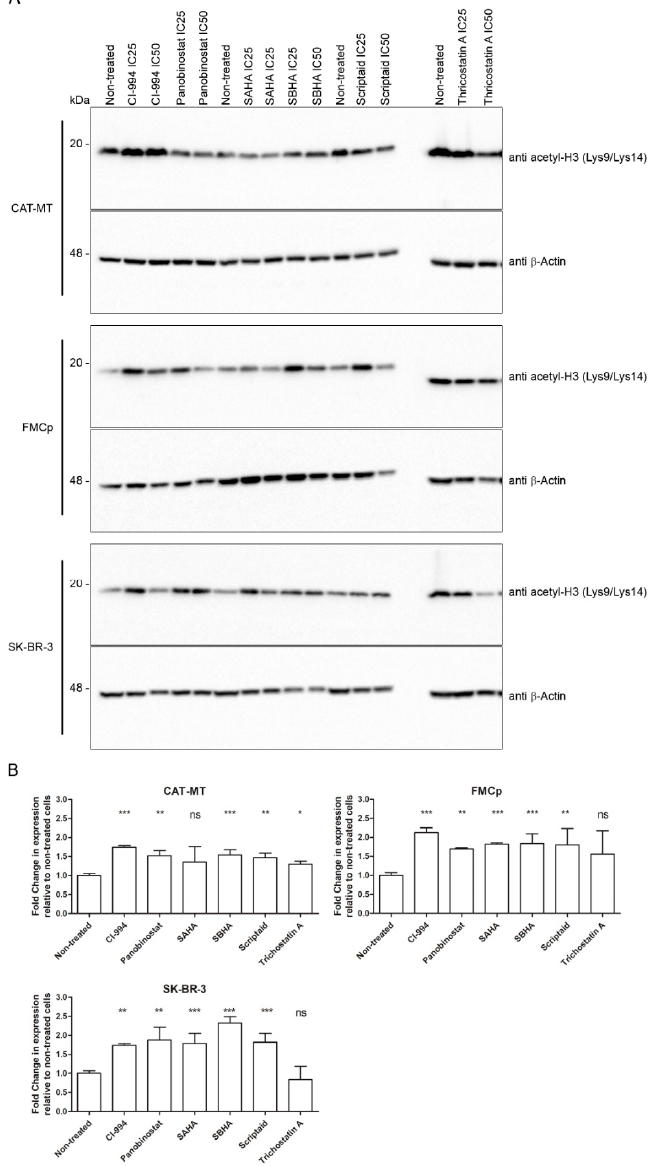
Figure 3. The cytotoxic effect of HDACis correlates with the acetylation status of the histone H3 (Lys9/Lys14). CAT-MT, FMCp, and SK-BR-3 cell lines were exposed to the correspondent IC50 of each HDACi for 72 h (for panobinostat and trichostatin A in the FMCp cell line, the IC50 values used were the ones obtained for CAT-MT). Cells were collected for total cell protein extracts and the levels of acetylation were assessed by ( A ) immunoblot with anti-acetyl-Histone H3 [Lys9/Lys14] antibody (Cell Signaling Technologies, Danvers, MA, USA) and ( B ) densitometry and compared to unexposed cells. DMSO (CI-994, panobinostat, SBHA, SAHA, scriptaid, and trichostatin ( A ) was used as vehicle control and sample loading was controlled with β -actin antibody (AC-15, Abcam, Cambridge, UK). In ( A ), a representative immunoblot is shown. Statistical analysis was performed in Graph Pad Prism software and p -values were calculated by a two-tailed unpaired Student’s t-test relative to non-treated cells (ns p > 0.05, * p ≤ 0.05, ** p ≤ 0.01, *** p ≤